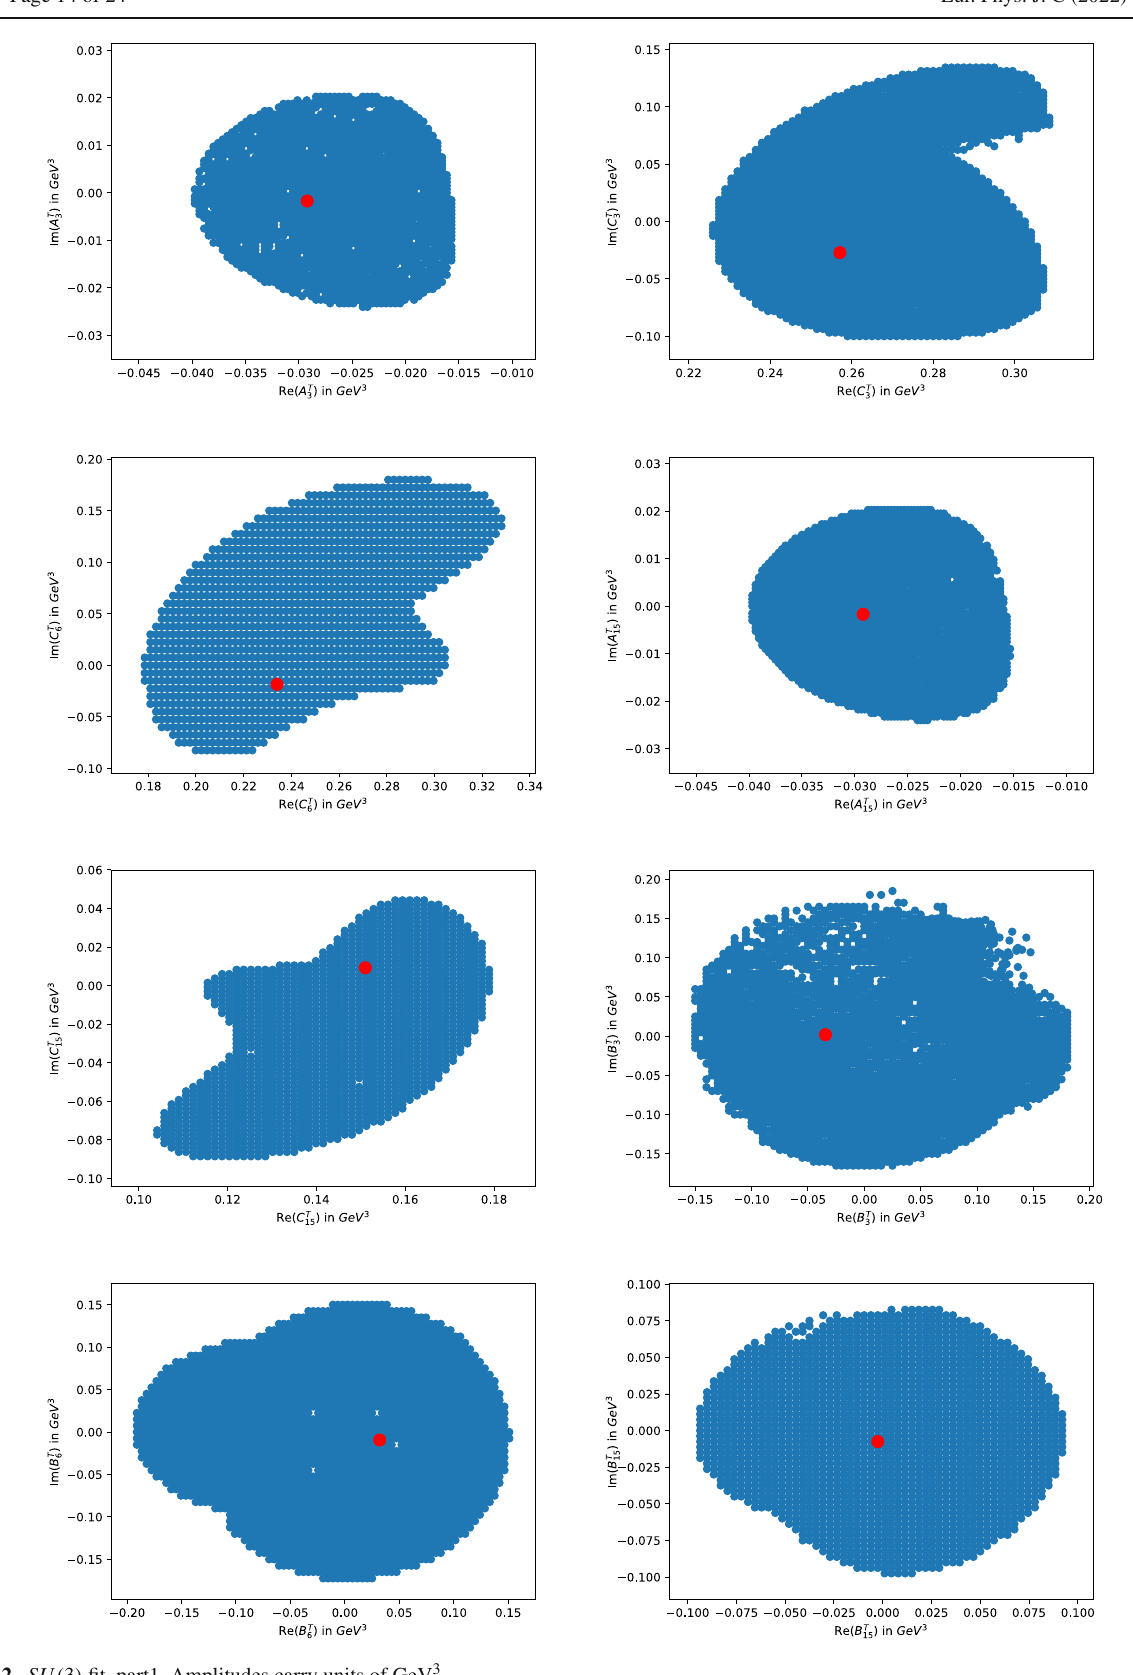
Fig. 2 SU ( 3 ) fit, part1. Amplitudes carry units of GeV